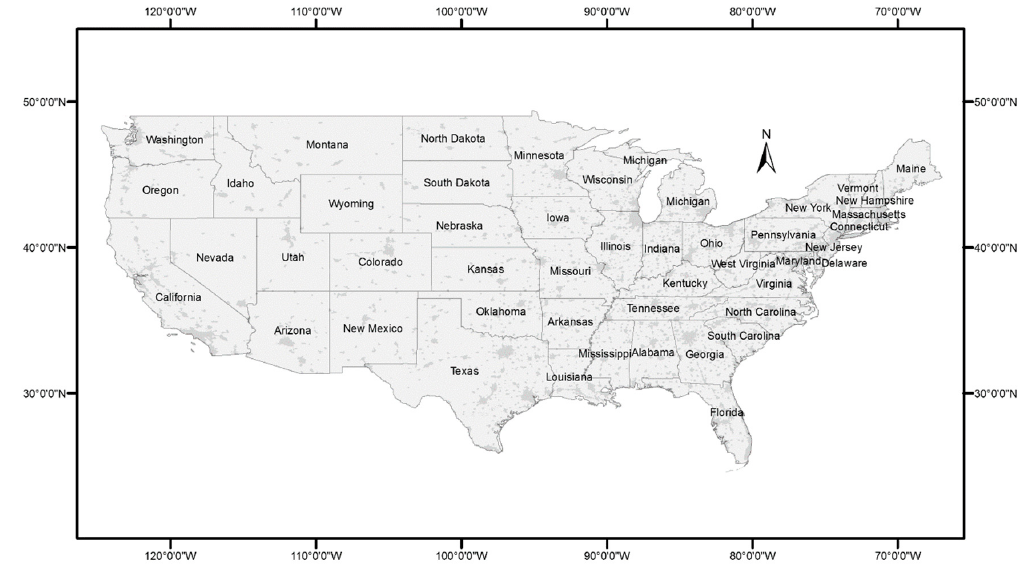
Figure 1. The study area consisting of the 48 conterminous states in the US, with urban extent data layer from the Global Rural–Urban Mapping Project (GRUMP) overlaid with state boundaries.